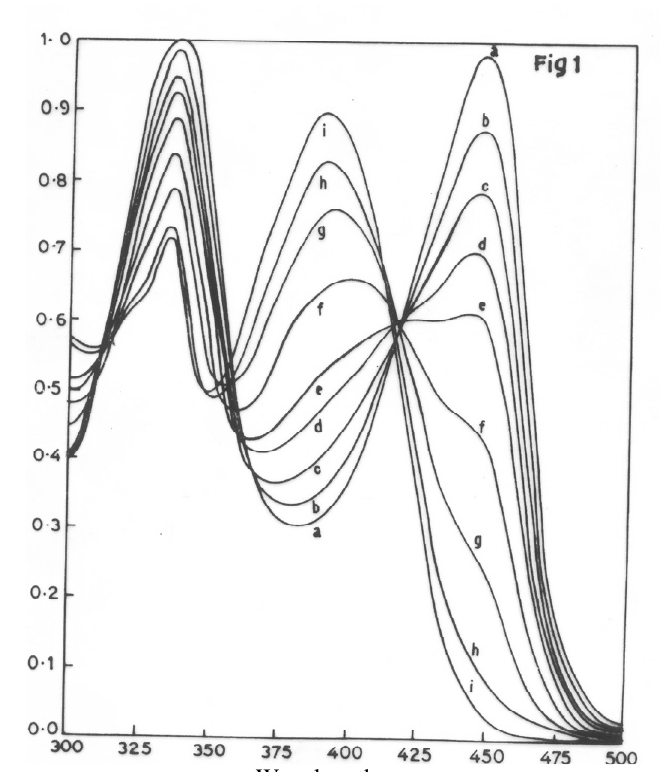
Figure 1 .Absorption spectra of Ni4M8Q + 4-methyl aniline mixtures in chloroform at 25 0 C. [NI4M8Q]: 12.10 X 10 -5 M, [4-Me-aniline] X 10 2 M: (a) 0.00 (b) 0.99 (c) 1.99 (d) 2.99 (e) 3.98 (f) 5.98 (g) 7.97 (h) 9.96 and (i)